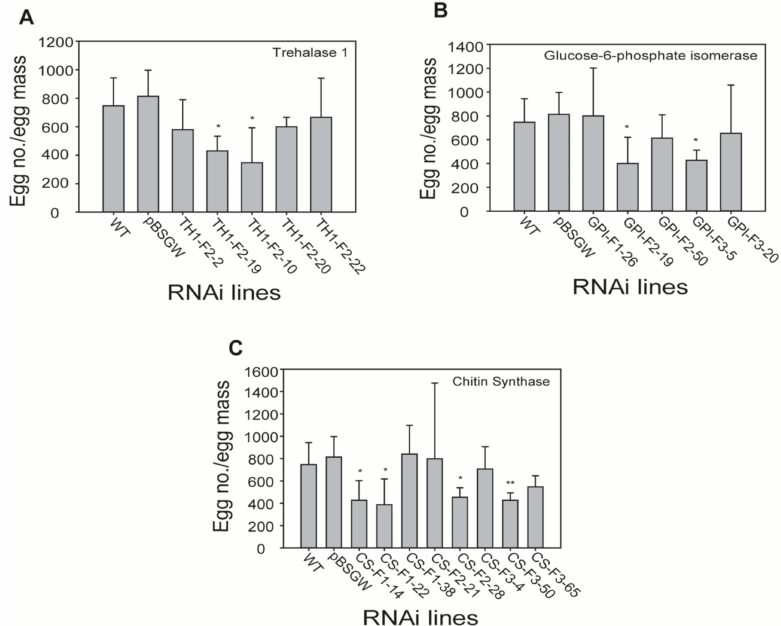
Figure 6. E ff ect of egg number per egg mass of Meloidogyne incognita feeding on transgenic Nicotiana benthamiana plants. ( A ) Trehalase 1 RNAi lines, ( B ) GPI RNAi lines, ( C ) CS RNAi lines. Each bar represents mean ± SD of three independent experiments with three technical replicates. Statistical analyses ( t -test) were conducted using SigmaPlot 12.5. For t -test analysis, WT data infected by nematode were used to compare with each RNAi line. Asterisk indicates significant di ff erences compared with wild-type (* p < 0.05 and ** p <